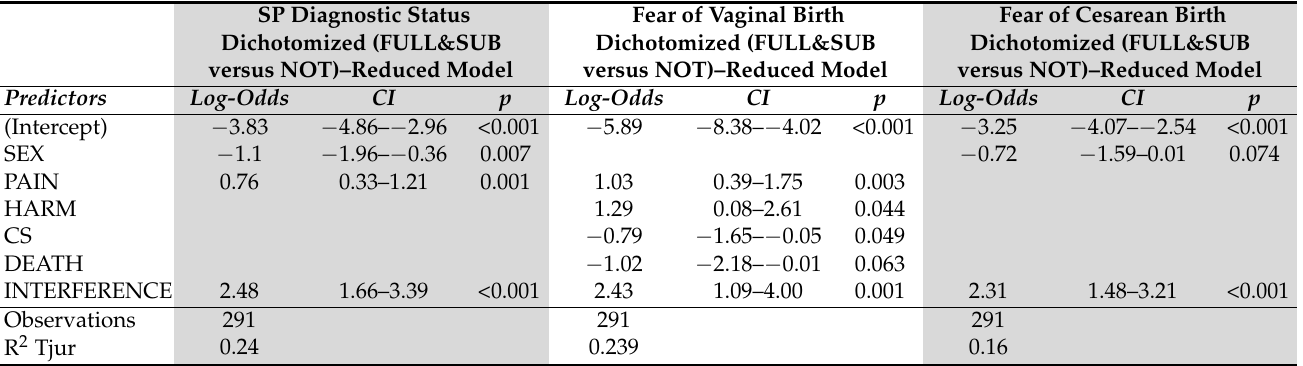
Table 7. Results of logistic regressions on CFQ subscales for multiparous